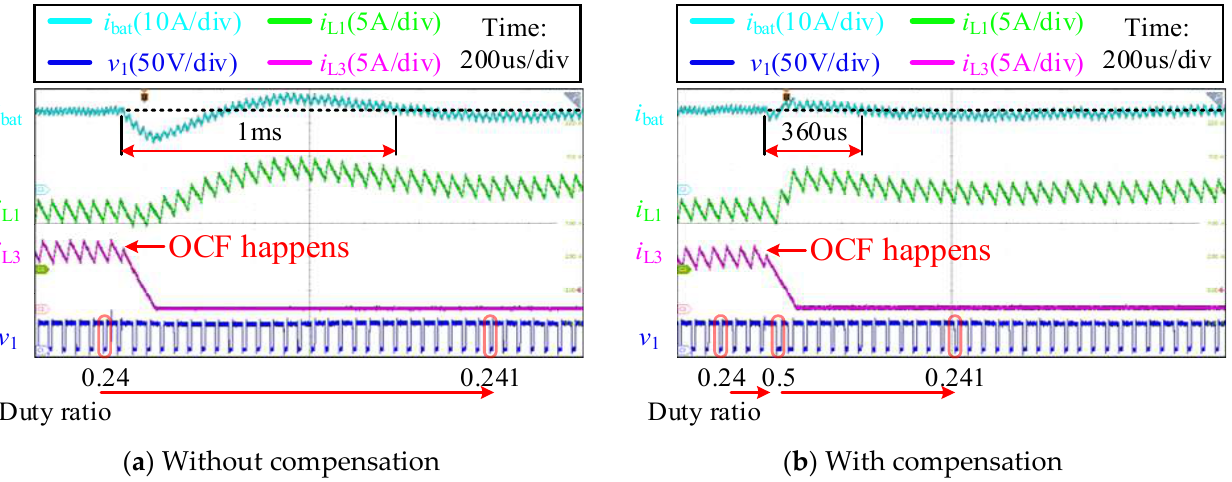
Figure 10. Changes of duty ratio and currents when OCF happens before and after compensation: ( a ) phase changes without compensation, number of phase changes from 3 to 2; ( b ) phase changes without compensation, number of phase changes from 3 to 2.